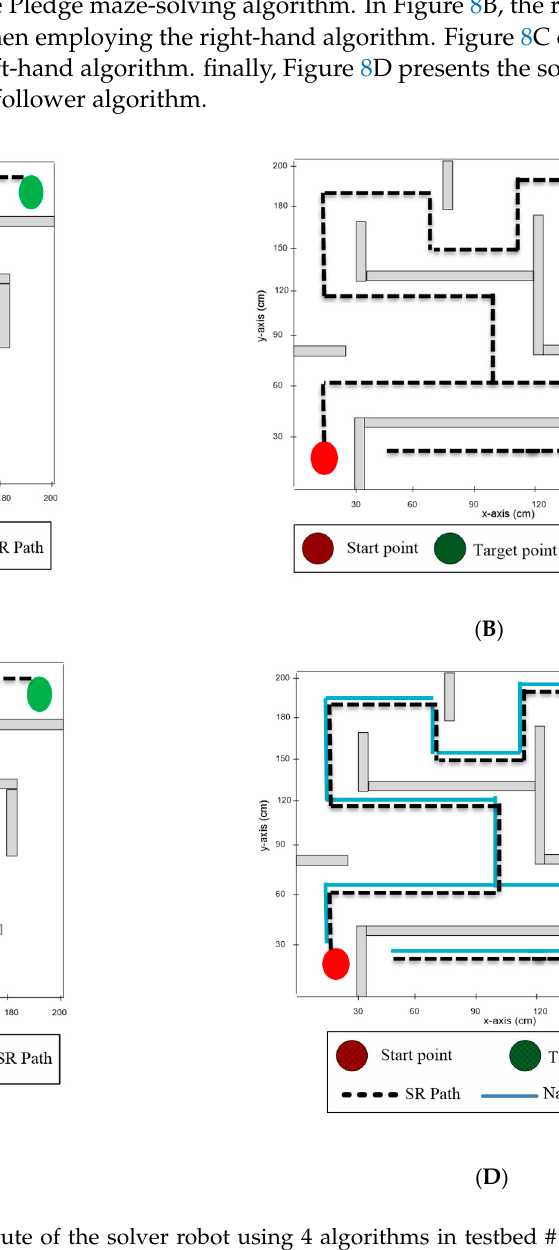
Figure 9. The total traveled distance of the solver robot for 4 algorithms in testbed # 1. In the second experiment testbed, the initial and the destination points were located in different positions, as presented in Figure 10. Table 7 shows the experimental results obtained from deploying four different maze-solving algorithms in maze area 2. As presented, the modified wall-follower algorithm and the right-hand algorithm required the minimum time and distance to reach the target location, with a total traveled distance of 495 cm. On the other hand, the left-hand rule needed the maximum time and distance, with a total traveled distance of 2031 cm. However, the total distance traveled was around 2526 cm for the modified wall-follower algorithm. This was because the modified wall-